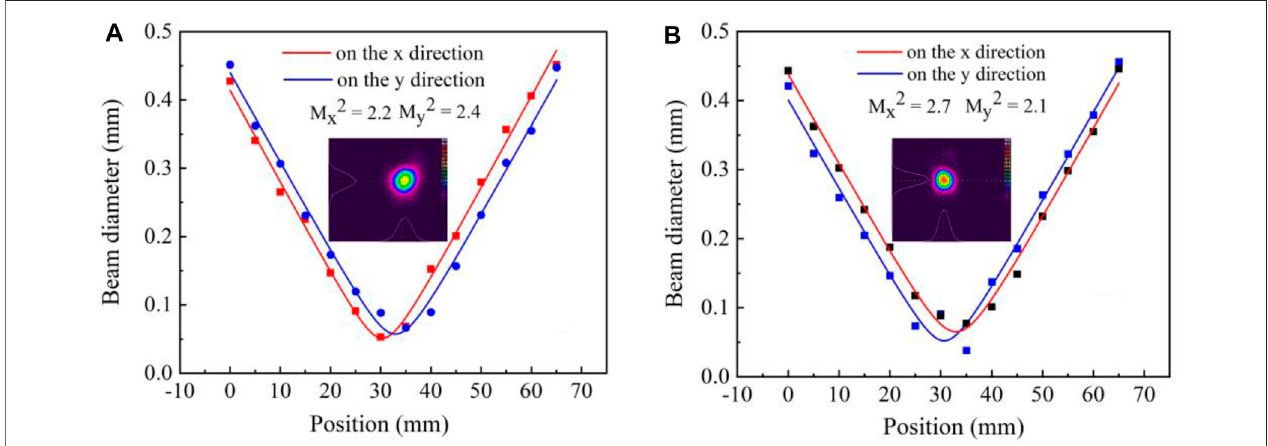
FIGURE 11 | Output beam diameter versus beam position on different directions for the 100-kHz repetition rate. (A) At output 1.08 mJ single-pulse energy with a pulse width of 10.3 ns. (B) At output 4.38 mJ single- pulse energy with a pulse width of 96.1